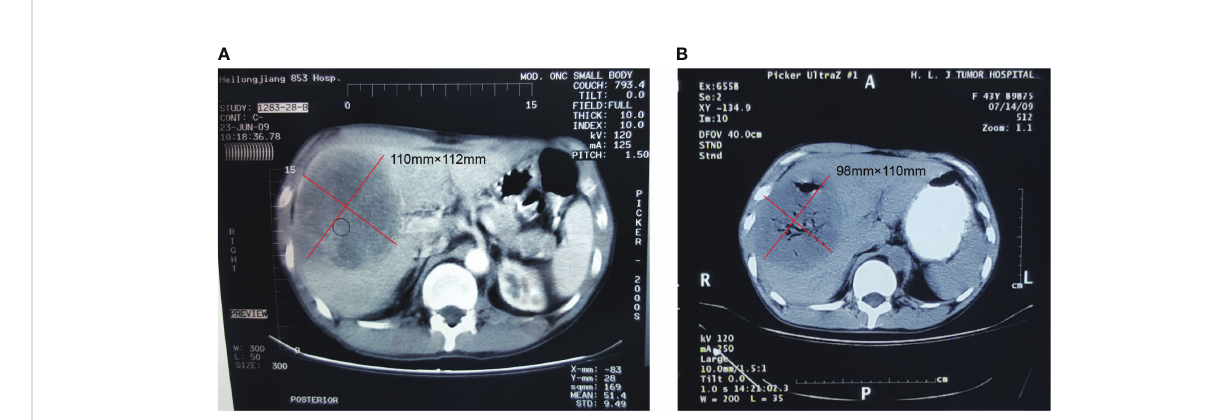
FIGURE 1 Contrast-enhanced computed tomography of the hepatic extra-gastrointestinal stromal tumor. (A) A 110 × 112 mm mass with solid and cystic components was observed in the right hepatic lobe, with an uneven enhancement in the arterial phase scan. (B) The hepatic mass was treated by argon-helium cryosurgery in July 2009, at which point the tumor was cystic and measured 98 × 110 mm.